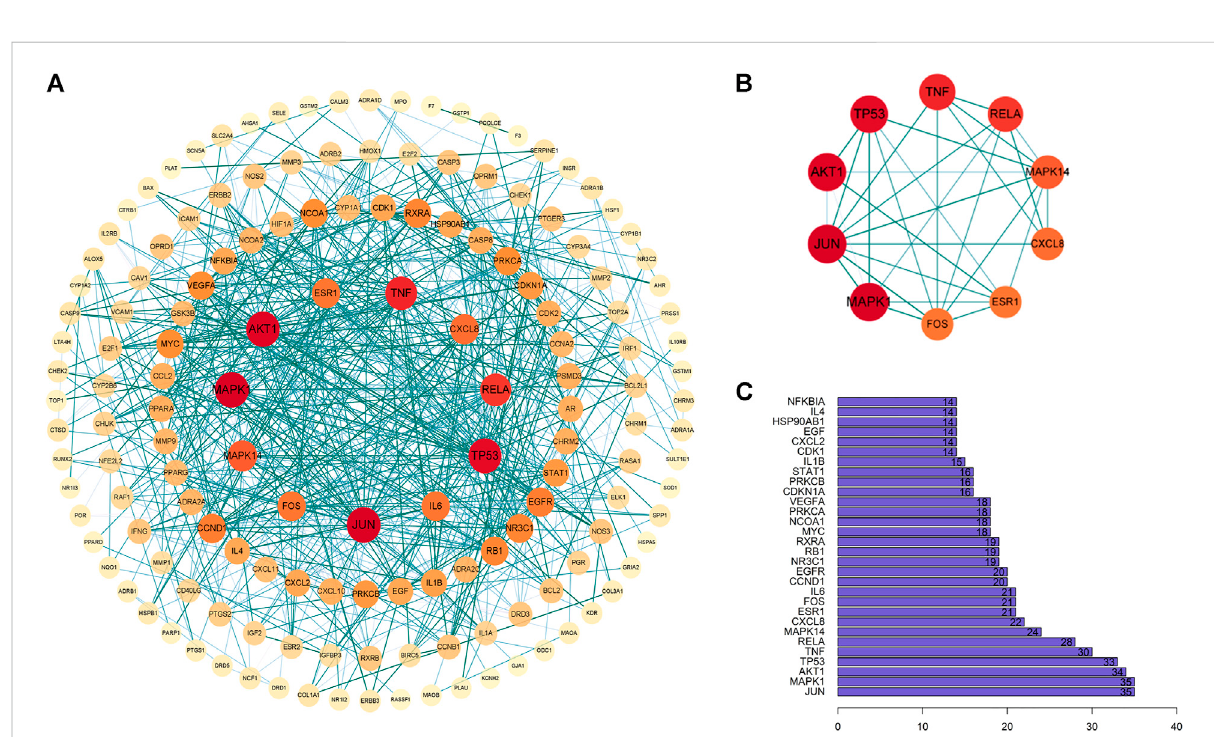
FIGURE 5 Interactionnetwork diagram ofPDtargetproteinsagainstcoloncancer. (A) PPI network of154duplicatetargets. (B) network ofthetop 10core proteins. (C) top 30 targets ranked by the degree